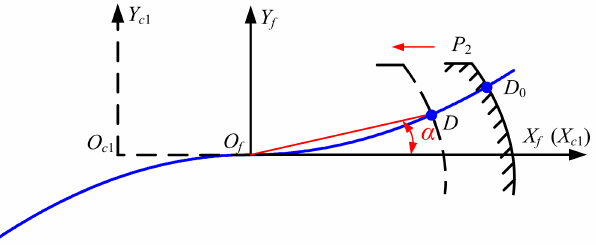
Figure 3. Derivation of the tooth profile of the rack-cutter based on path of